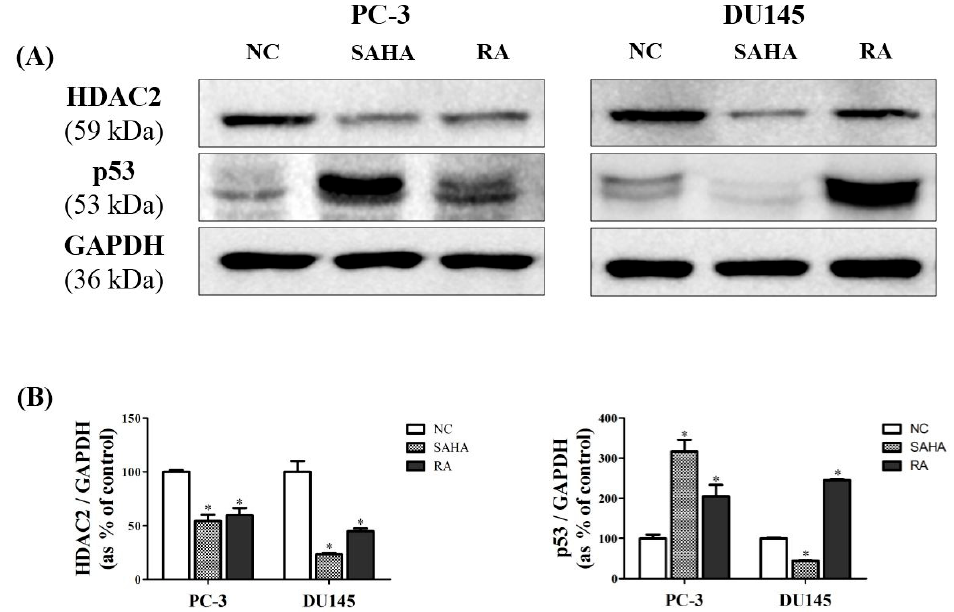
Figure 5. Effects of SAHA and RA on expression of histone deacetylase 2 (HDAC2) and p53 in PC-3 and DU145 cell lines. After both cell lines were seeded at 1 × 10 6 in cell culture dishes and treated with media containing NC (DMSO), SAHA (1 μ M) and RA (200 μ M), the western blot analysis was performed. ( A ) The expressions of HDAC2 and p53 at the protein level were confirmed by western blot analysis. ( B ) The expression levels of HDAC2 and p53 were quantified and normalized to glyceraldehyde-3-phosphate dehydrogenase (GAPDH). The results are expressed as means ± SD. * p < 0.05: a significant difference versus control.